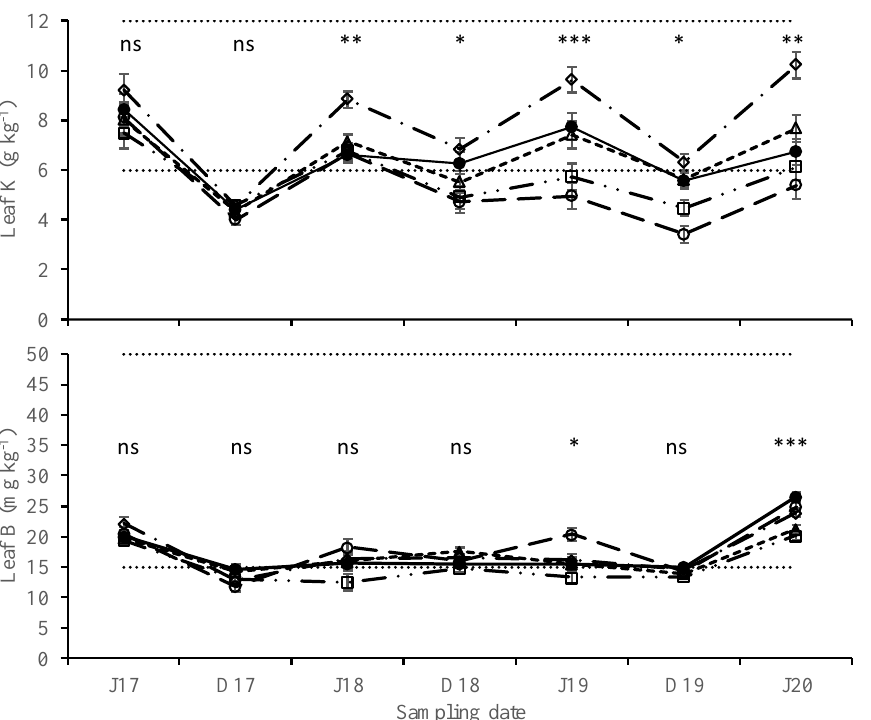
Figure 5. Leaf nitrogen (N), phosphorus (P), potassium (K) and boron (B) concentrations in seven consecutive sampling dates in July (J) and December (D) from July 2017 (J17) to July 2020 (J20). Horizontal dashed lines are the lower and higher limits of the sufficiency ranges; ns (not significant), * ( p < 0.05), ** ( p < 0.01) and *** ( p < 0.001) are the results of analysis of variance.